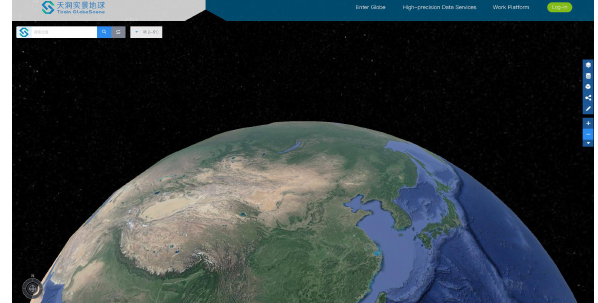
Fig.3 TIRAIN 3D Real-Scene Monitoring Platform